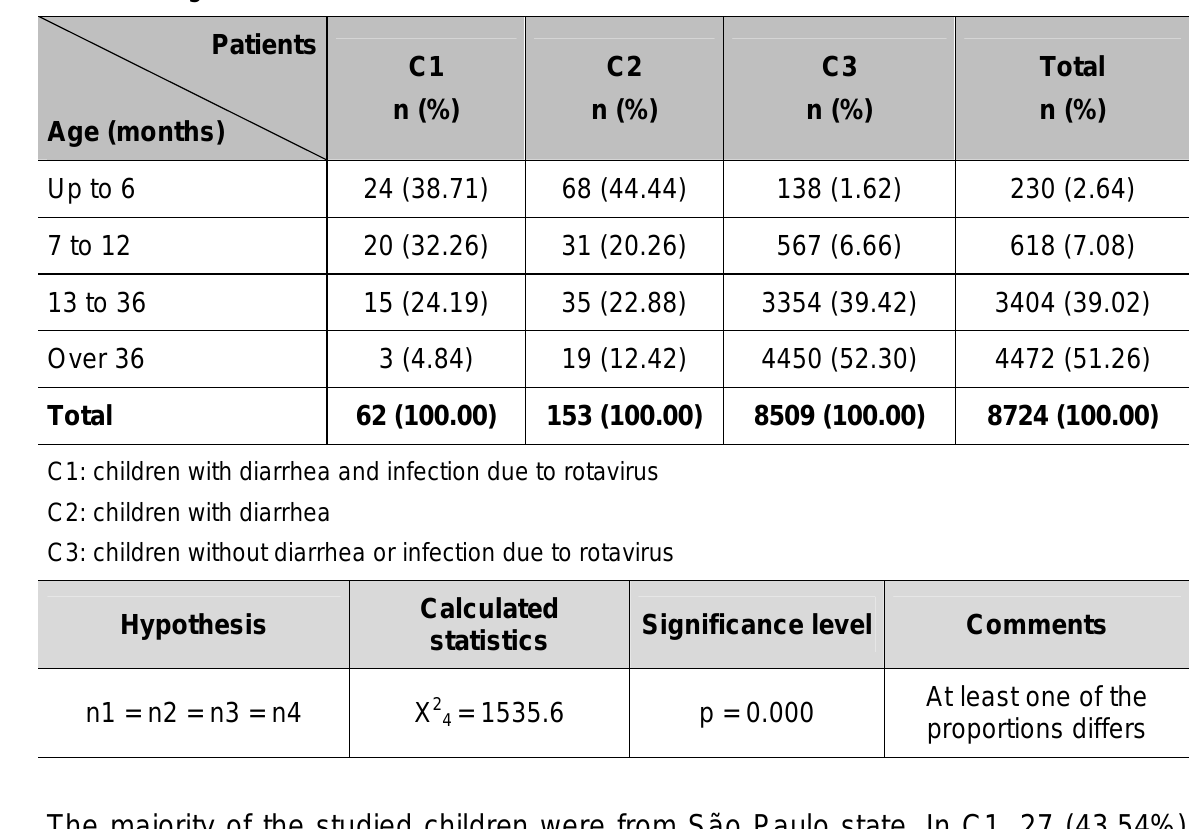
Table 1. Age distribution of 8,724 children with craniofacial